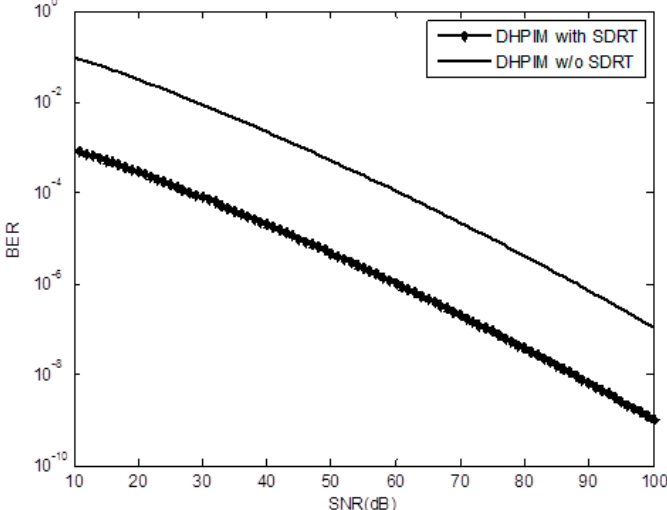
Figure 11. BER performance of DH-PIM with SDRT and without SDRT in a moderate turbulence channel.